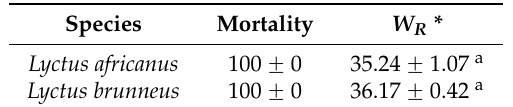
Table 2. Average mortality and W R of larvae of L. africunus and L. brunneus (% (mean ˘ SD)) after treatment at 40 ˝ C and 1.1 kPa for 4 h ( n =